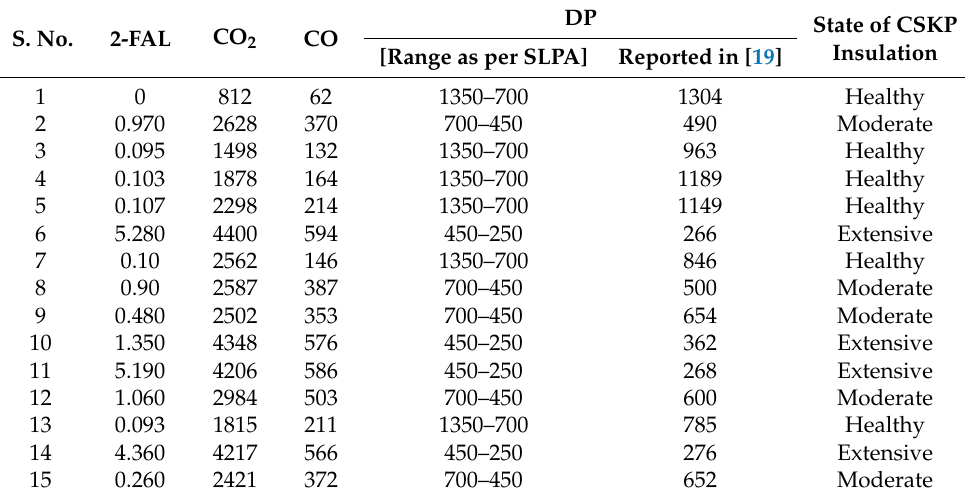
Table 6. Validation of insulation status using